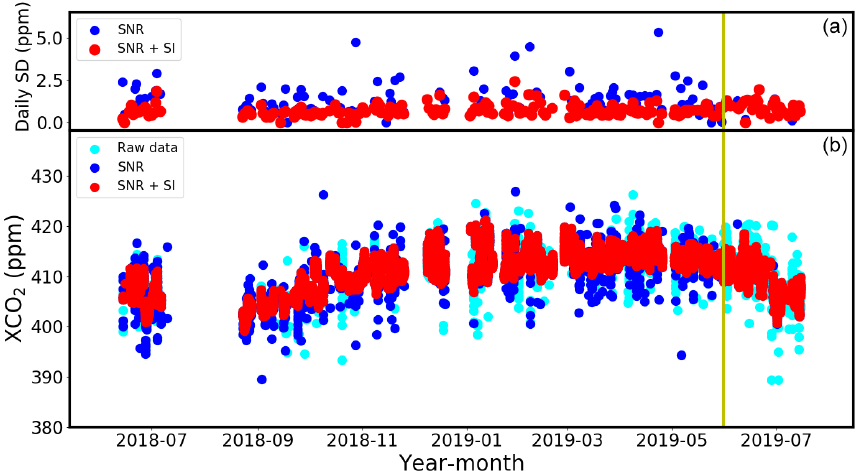
Figure 6. Time series of XCO 2 from 14 June 2018 to 19 July 2019 before and after spectra selection. The cyan dots denote all the raw data, the blue dots in (b) are the retrieved XCO 2 after SNR filtering and the red dots are the retrieved XCO 2 after SNR + SI filtering. In (a) , the blue dots denote the daily standard deviation of XCO 2 only with SNR filtering while the red ones denote those with SNR + SI filtering. The yellow line denotes the day (31 May 2019) when we added the DC signal